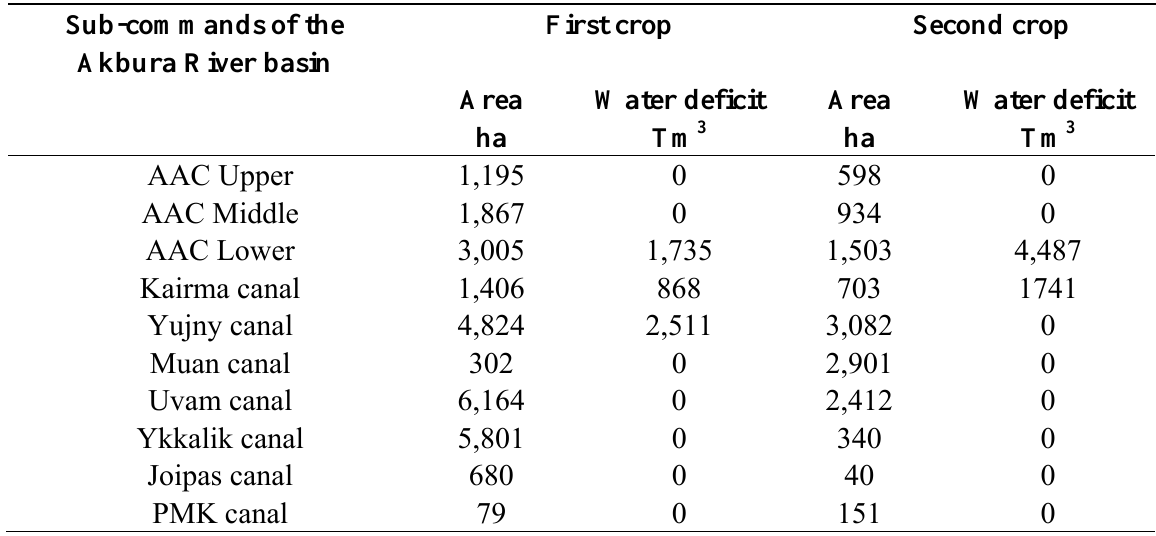
Table 6. Simulation of first and second cropping areas under user participatory water